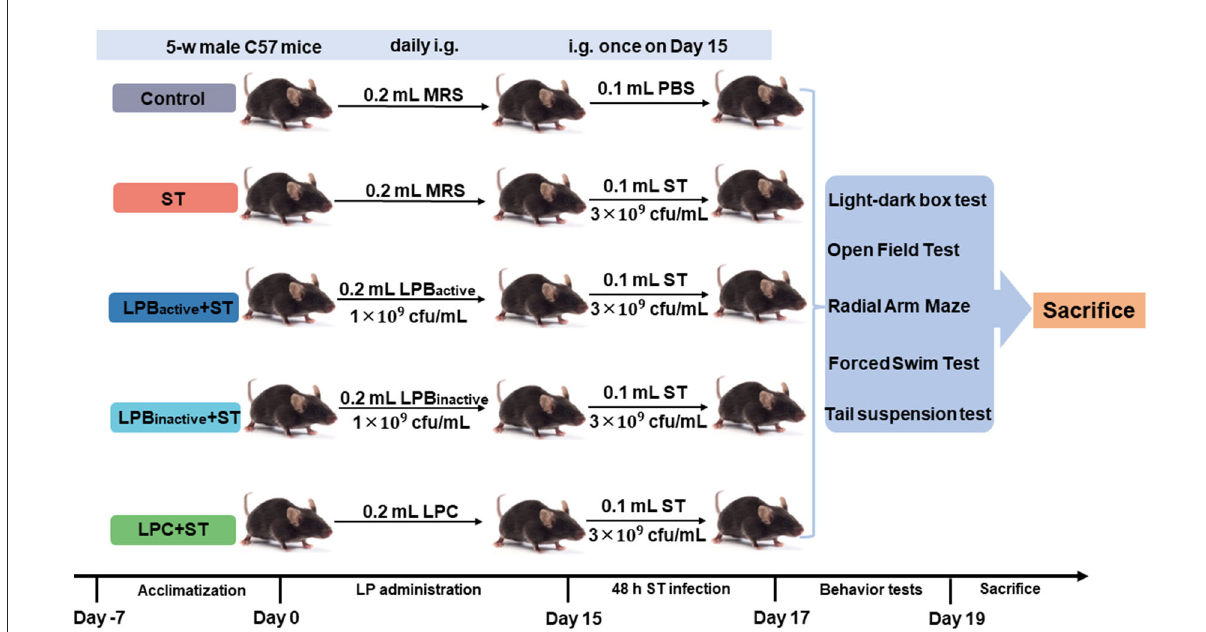
FIGURE1 Schematic diagram displaying the experimental design. The experiment was conducted in three sequential stages. Mice were intragastrically gavaged (i.g.) daily with 0.2ml of LP postbiotics for 15 days, and then i.g. with 0.1ml of 3 × 10 9 cfu/ml ST. Forty-eight hours post infection, mice were carried out to do behavior tests for 2 days, and were finally sacrificed the next